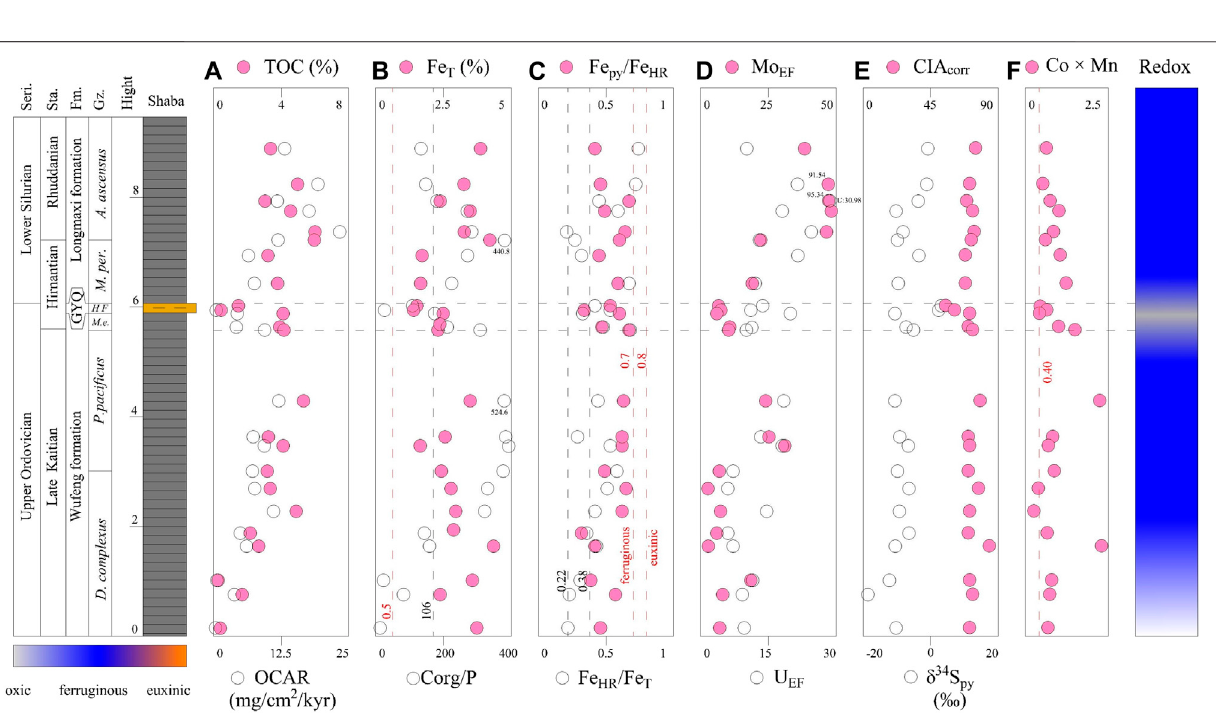
Frontiers in Earth Science |